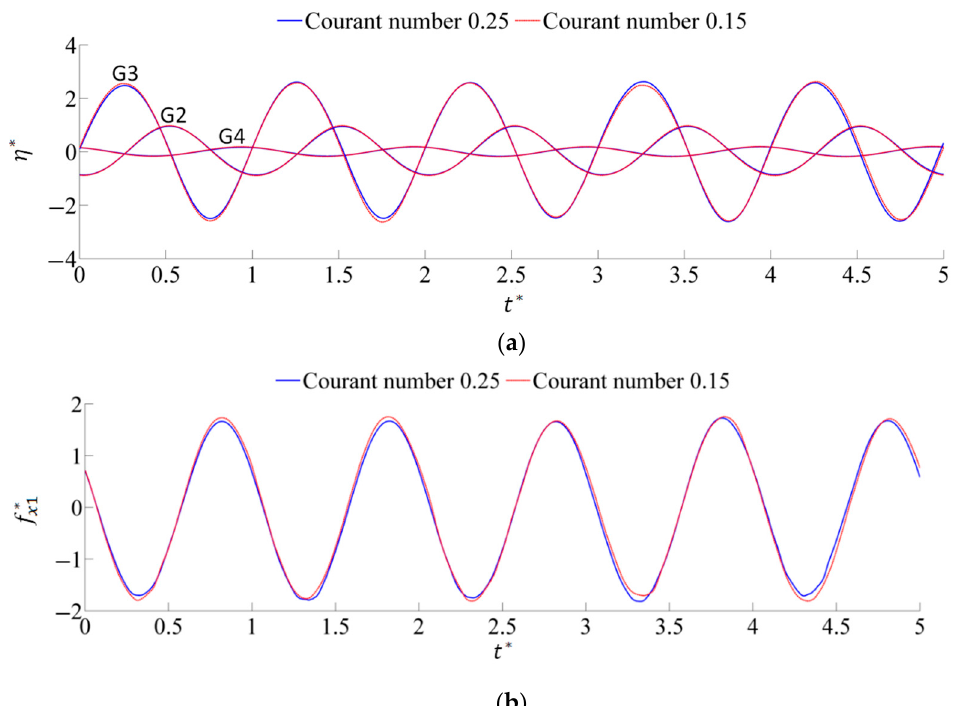
Figure 5. Time history curves of C6 using different time-steps over five steady-state periods: ( a ) 𝜂 ∗ versus 𝑡 ∗ at G2, G3, and G4; ( b ) 𝑓 (cid:3051)(cid:2869)∗ versus 𝑡 ∗ .